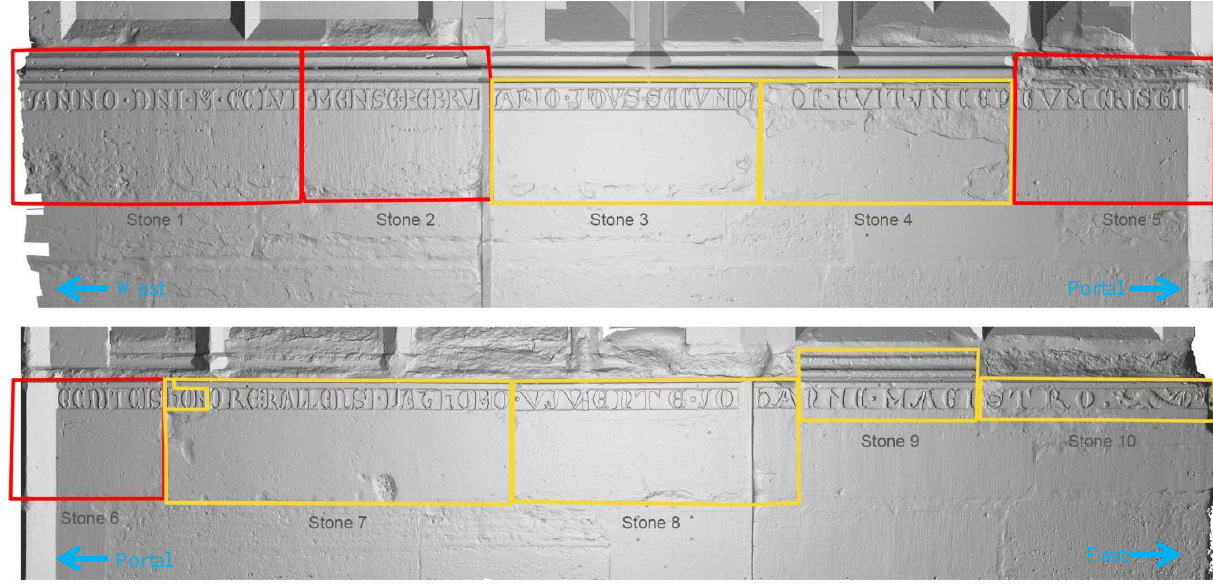
Figure 2. Orthoimages of the high-resolution models of the ten stones of the inscription. Red framed stones: 19 th century replacement; yellow framed stones: medieval original.